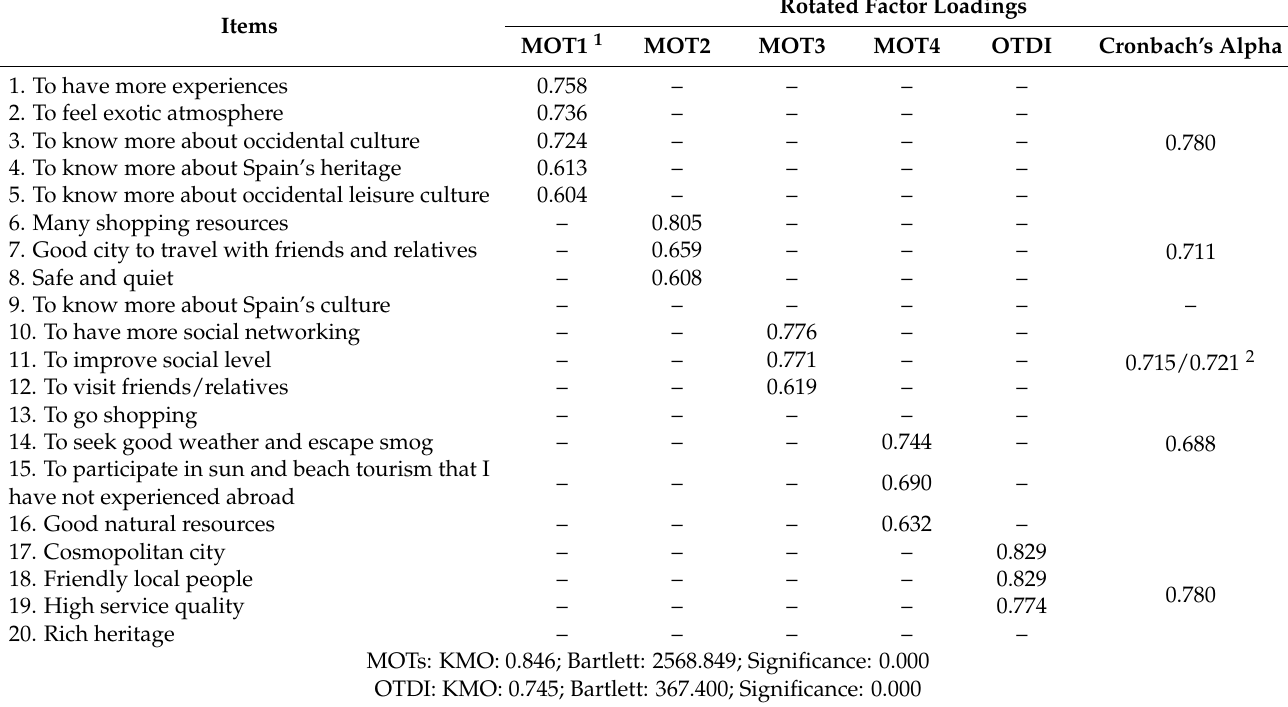
Table 4. Principal component analysis of travel motivations and overall